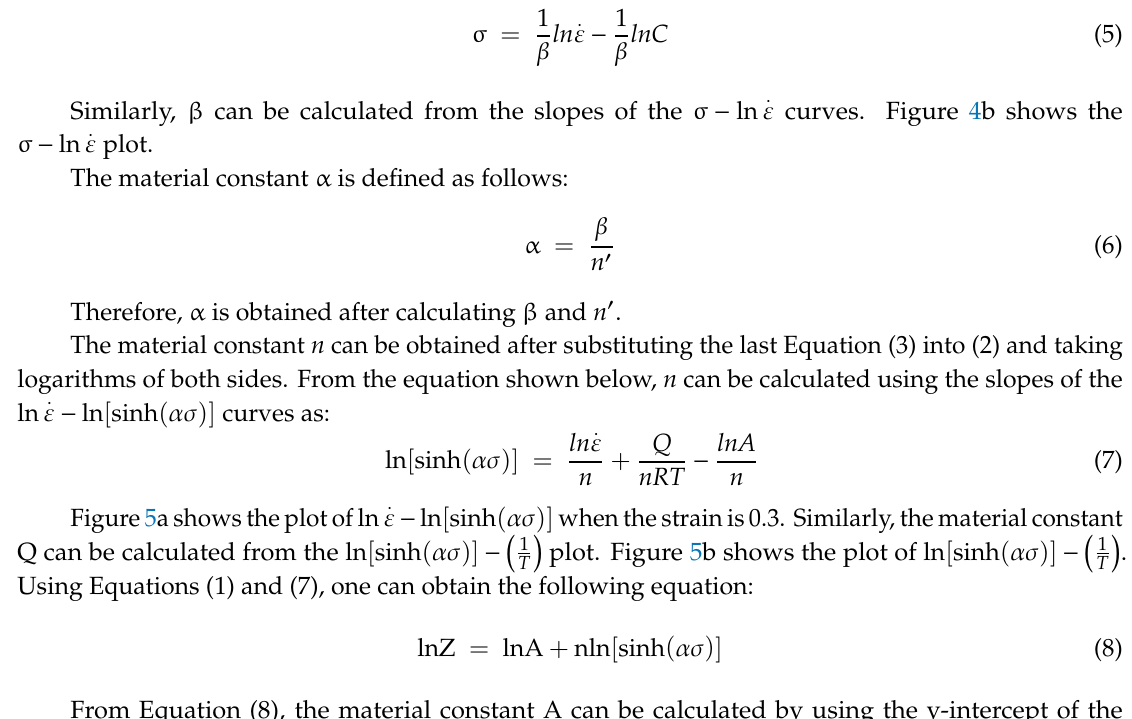
Figure 4. ( a ) ln σ − ln𝜀(cid:4662) plot and ( b ) σ − ln𝜀(cid:4662) plot when strain is 0.3.